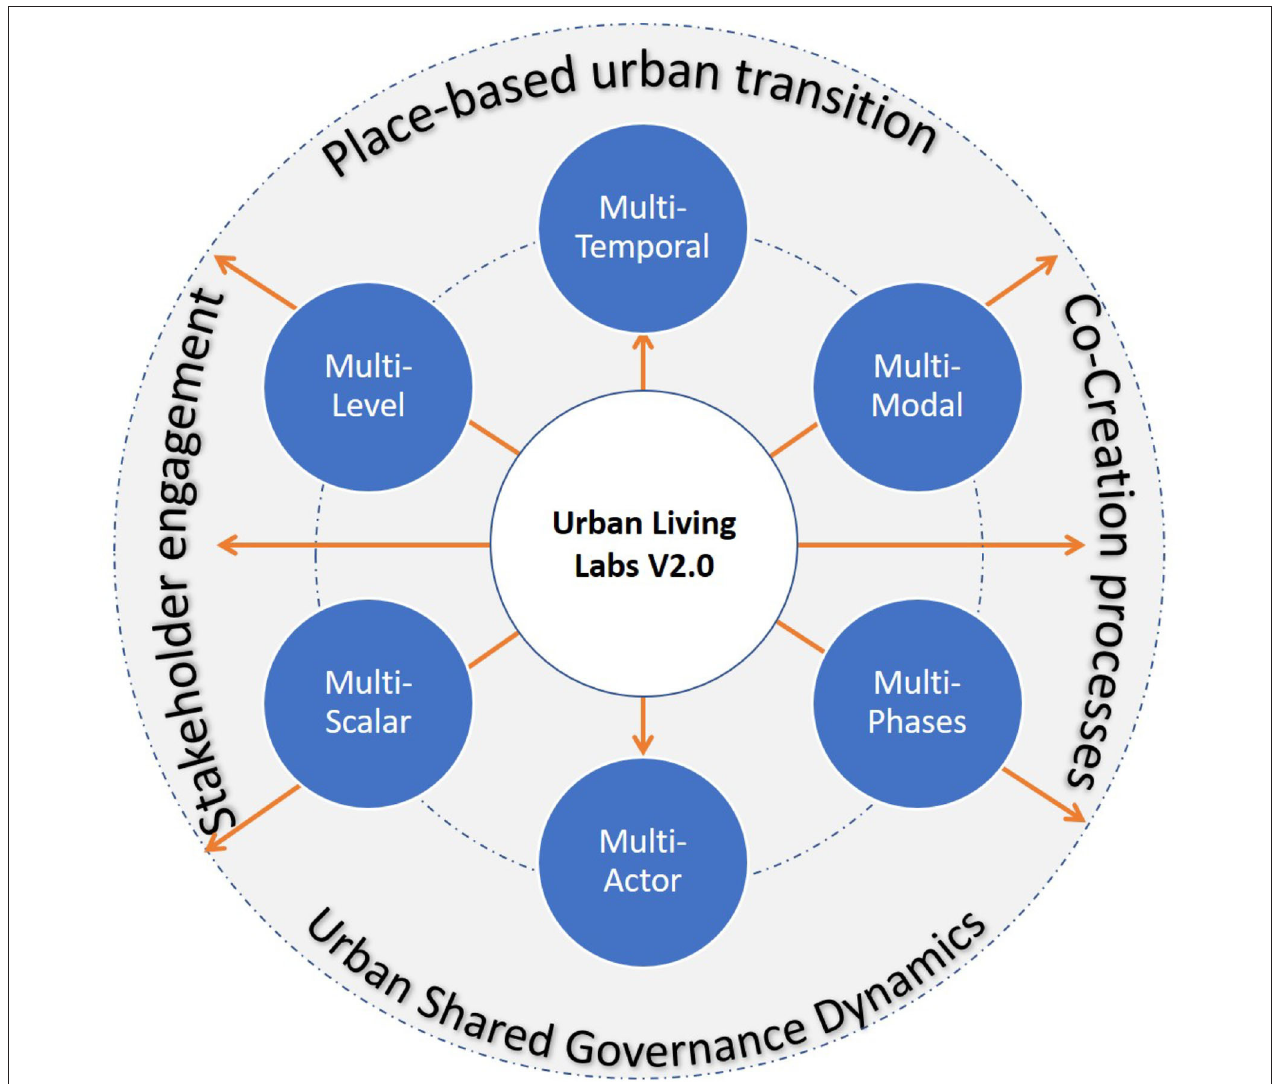
FIGURE 2 | Conceptual Urban Living Labs v 2.0 mechanism of development toward urban shared governance dynamics (Source: the authors).